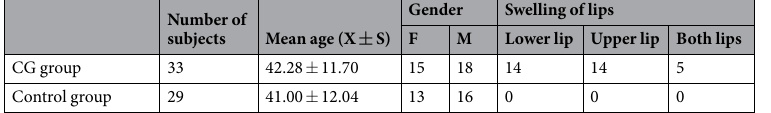
Table 1. Baseline information of the CG and control groups.